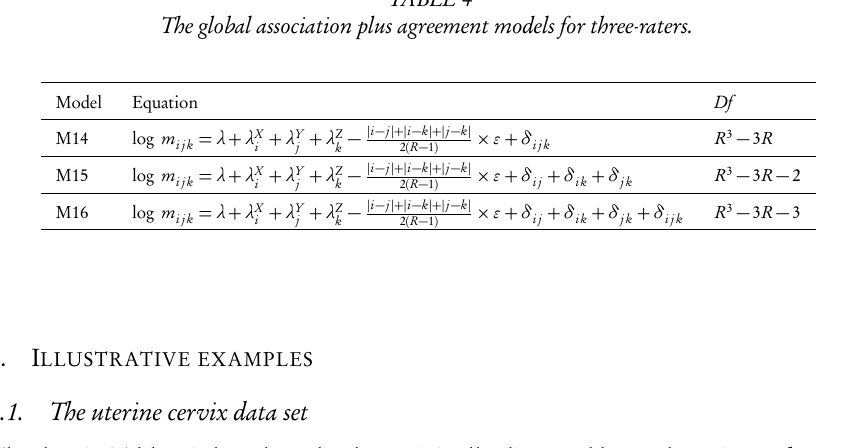
The global association plus agreement models for three-raters.